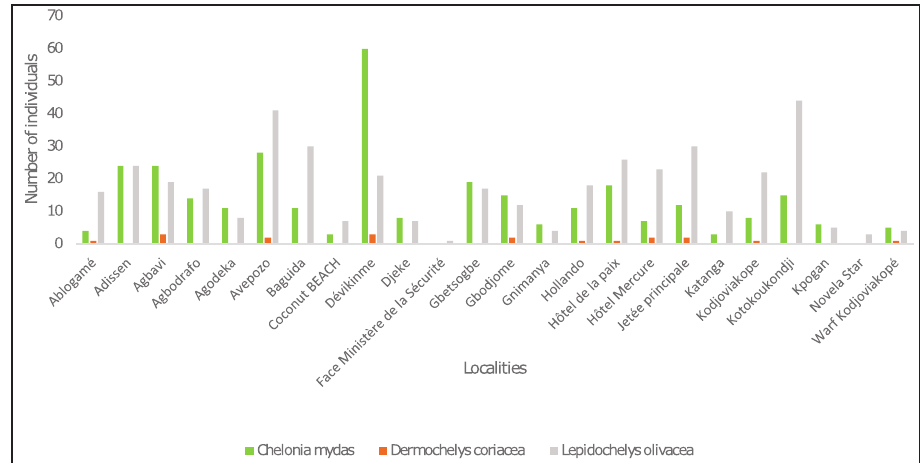
Figure 4. Distribution of marine turtle occurrences by species and location on the Togolese